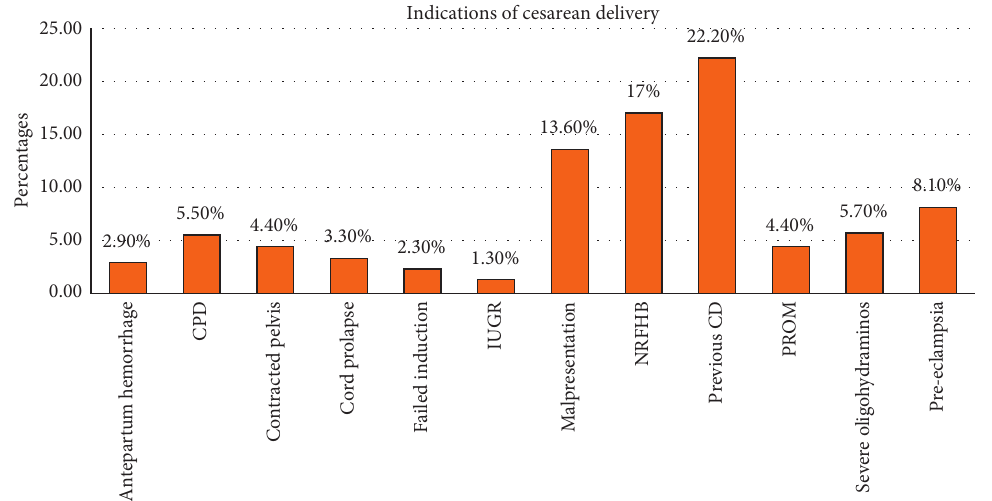
Figure 1: Reasons for cesarean delivery in University of Gondar Comprehensive Specialized Hospital, Northwest Ethiopia, 2019 ( N � 383). CPD: cephalopelvic disproportion, IUGR: intrauterine growth retardation, NRFHB: non-reassuring fetal heart beat, PROM: premature rapture of the membrane, and CD: cesarean